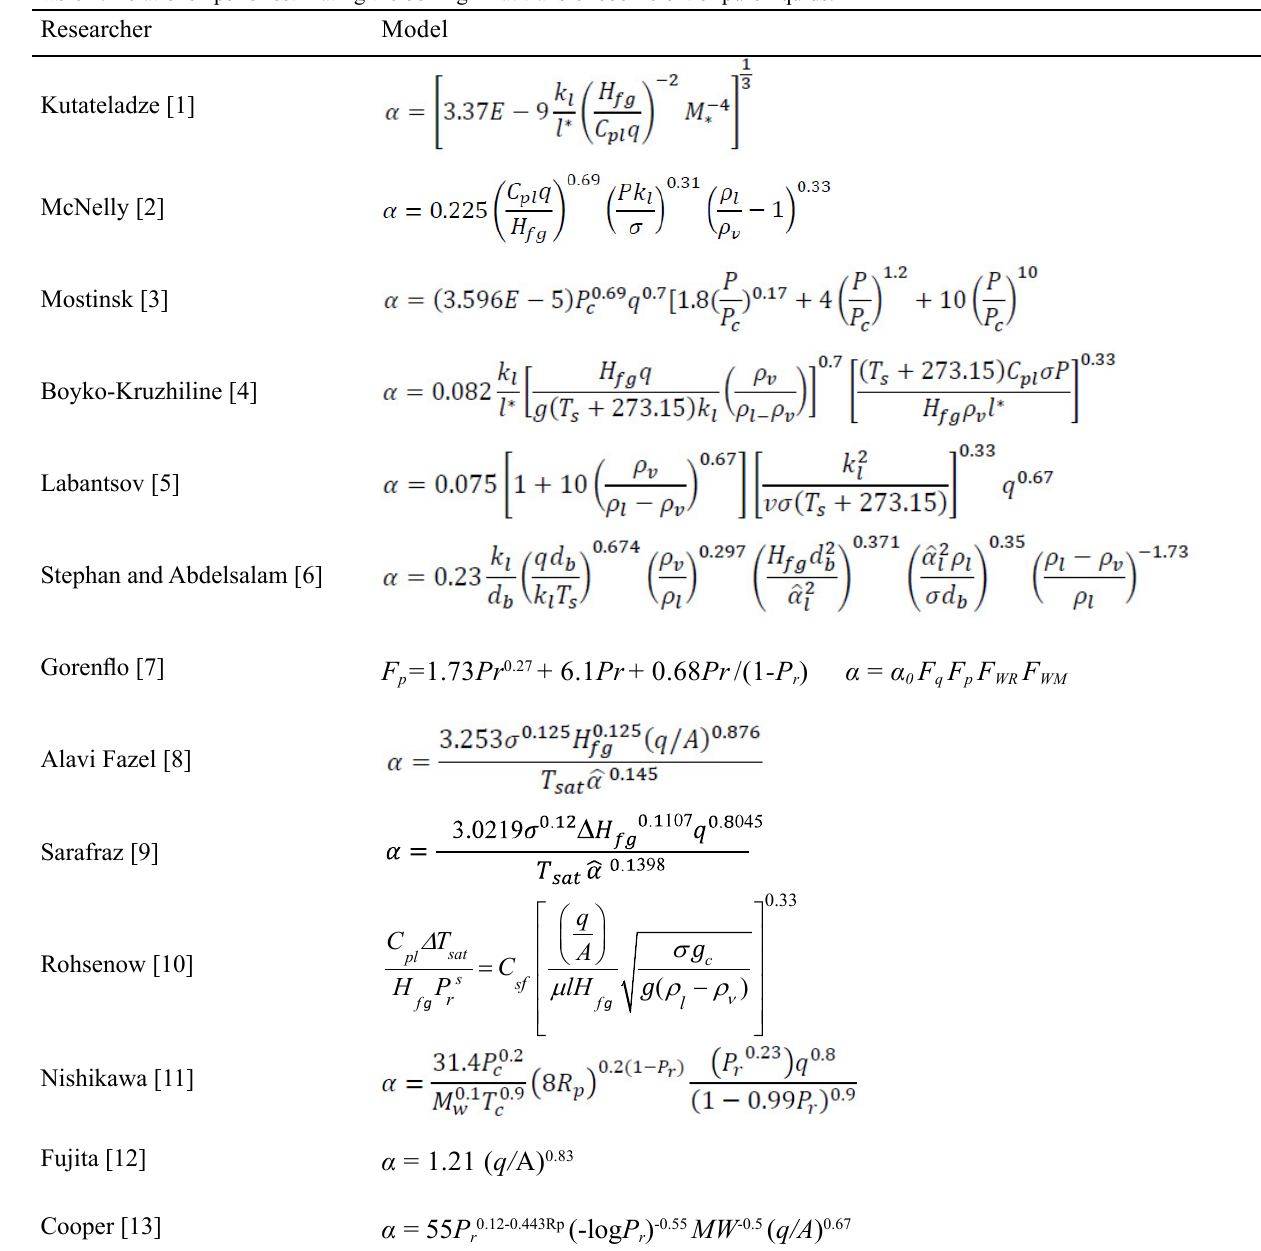
Table 1. Relationships for estimating the boiling Hhat transfer coefficient of pure liquids.